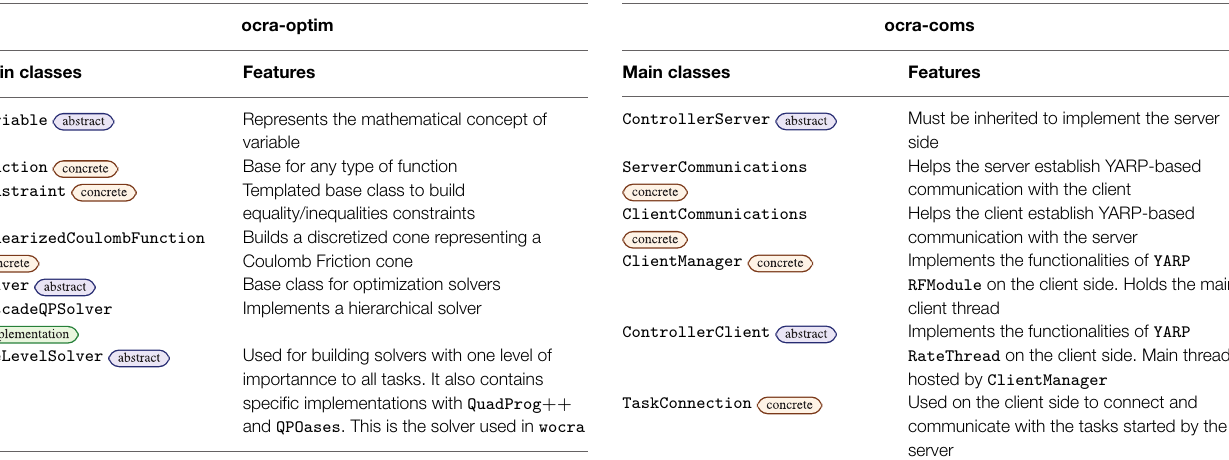
TABLE 4 | Main classes composing the ocra-optim library.